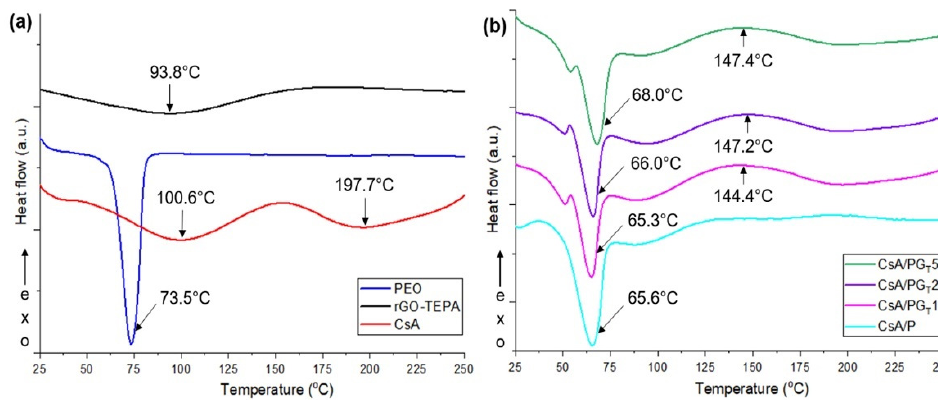
Figure 7. DSC curves of ( a ) raw materials, and ( b ) all investigated nanofibrous membranes.